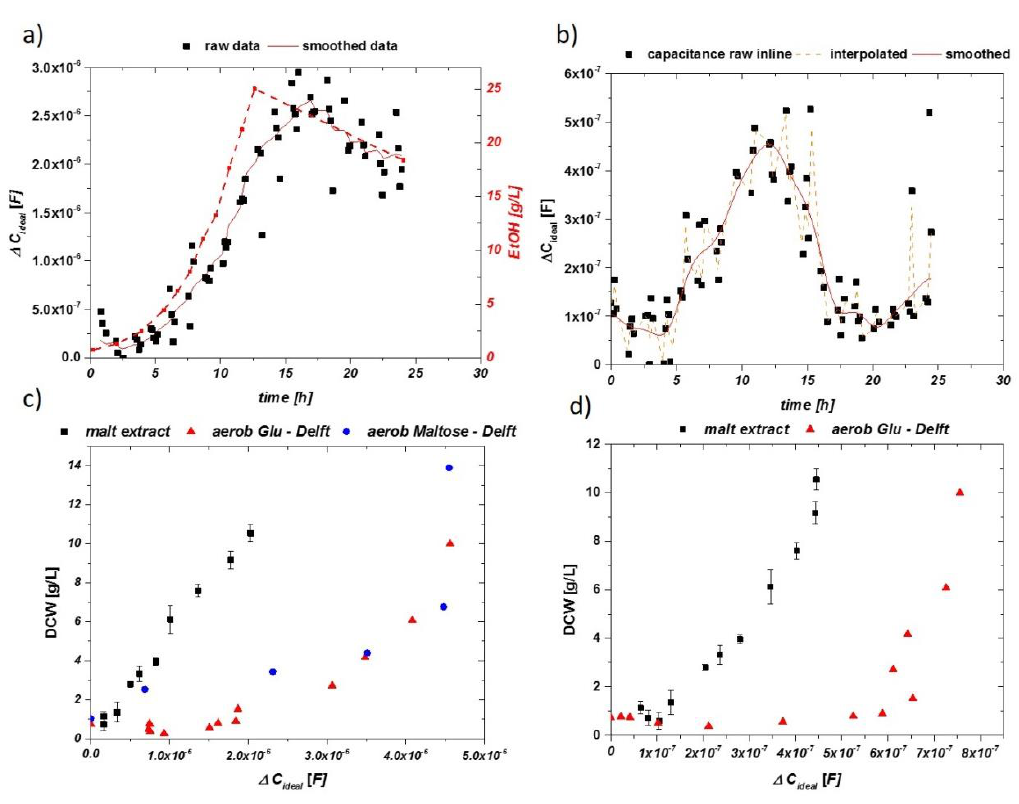
Figure 8. ( a ) Impedance signal over the cultivation time for the online probe using only malt extract as growth media. The line (orange) shows the interpolation procedure. As for related aerobic cultivation, a drop in the impedance is observed after consumption of sugars. ( b ) Impedance signal raw data, interpolated and smoothed for the inline probe. ( c ) Normalized impedance signal vs. DCW for the online probe using malt extract compared to defined media. ( d ) Normalized impedance signal vs. DCW for the inline probe using malt extract and defined media with glucose.